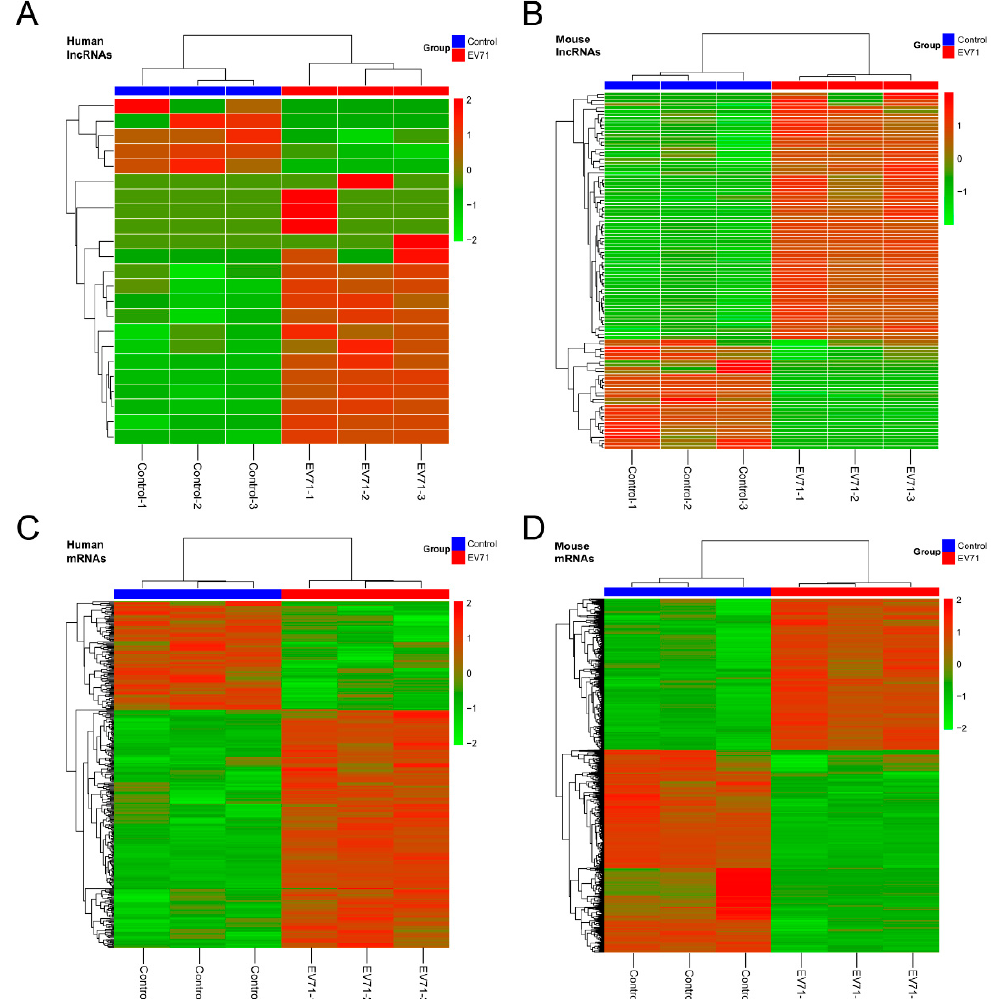
Figure 4. Heat maps of differentially-expressed gene expression ratios (log 2 FC) in EV71-infected human RD cells and skeletal muscle of neonatal mice. Differentially-expressed lncRNAs in RD cells ( A ) and skeletal muscle of mice ( B ) after EV71 infection. Differential expression profiles of mRNAs in RD cells ( C ) and skeletal muscle of mice ( D ). Red and green color denotes high relative expression and low relative expression, respectively.